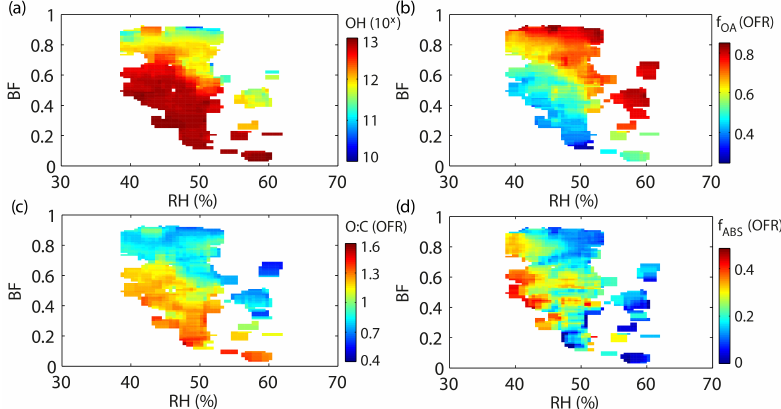
Figure 5. Scatterplot between BF, impactor RH and particle properties measured through the OFR; (a) (RH, BF) data colored with exposed OH concentration (10 x moleccm − 3 s), (b) (RH, BF) data colored with organic mass fraction of the particles derived from AMS results, (c) (RH, BF) data colored with O:C derived from AMS analysis, (d) (RH, BF) data colored with mass fraction of ammonium bisulfate derived from AMS analysis and composition categorization as in Cerully et al. (2015). Data are filtered by precipitation <1mmh − 1 and ambient aerosols f OA ≥ 0 . 6.